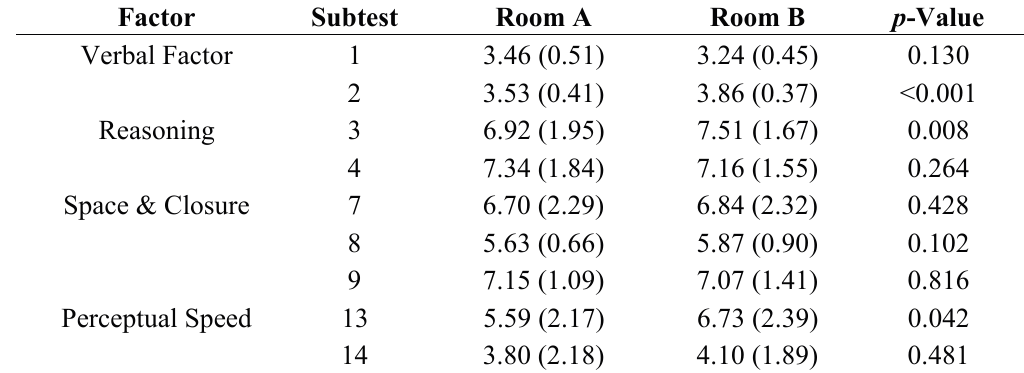
Table 2. Cognitive performance tested by Horn’s test. Means (SD) for rooms A and B (the room with higher air ion concentration). Values are standardized C scores. Higher values define a better cognitive performance. p -values from factor room type of analysis of variance.